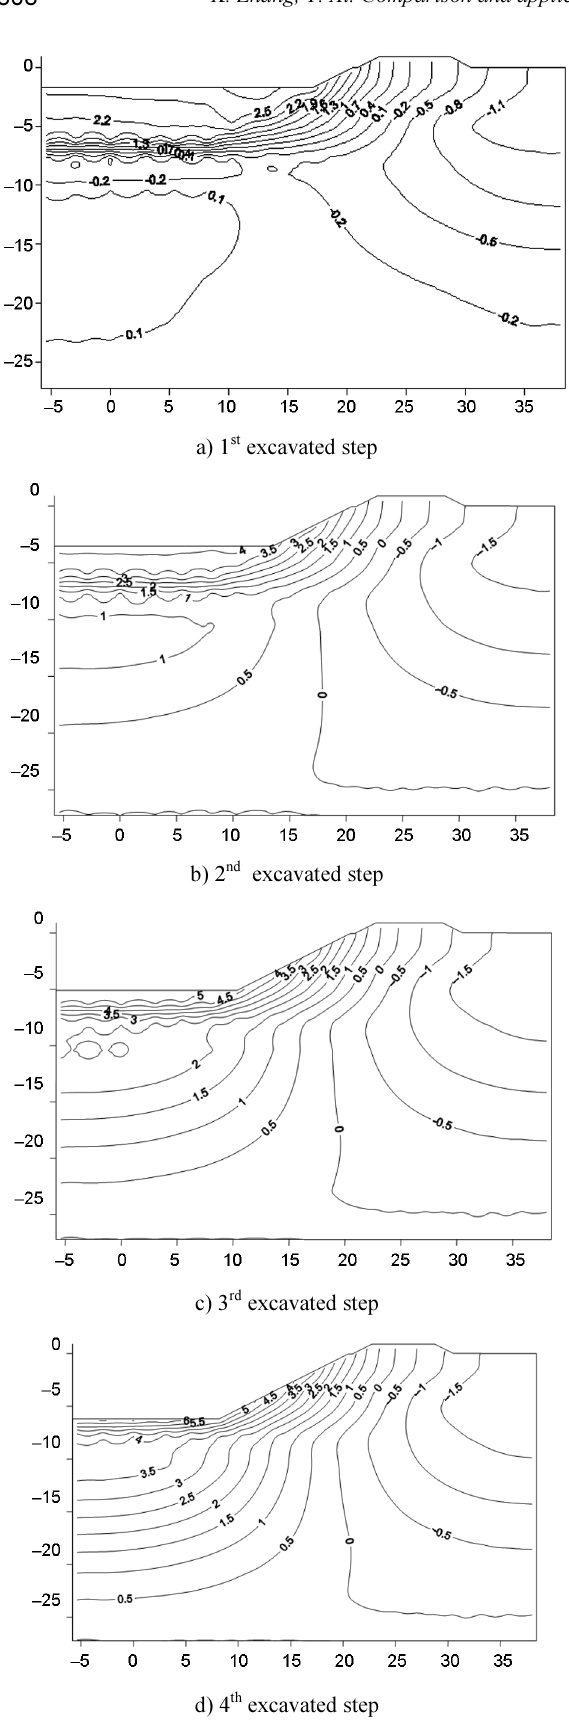
Fig. 8. Calculated vertical displacement (Modified Sekiguchi- Ohta model)